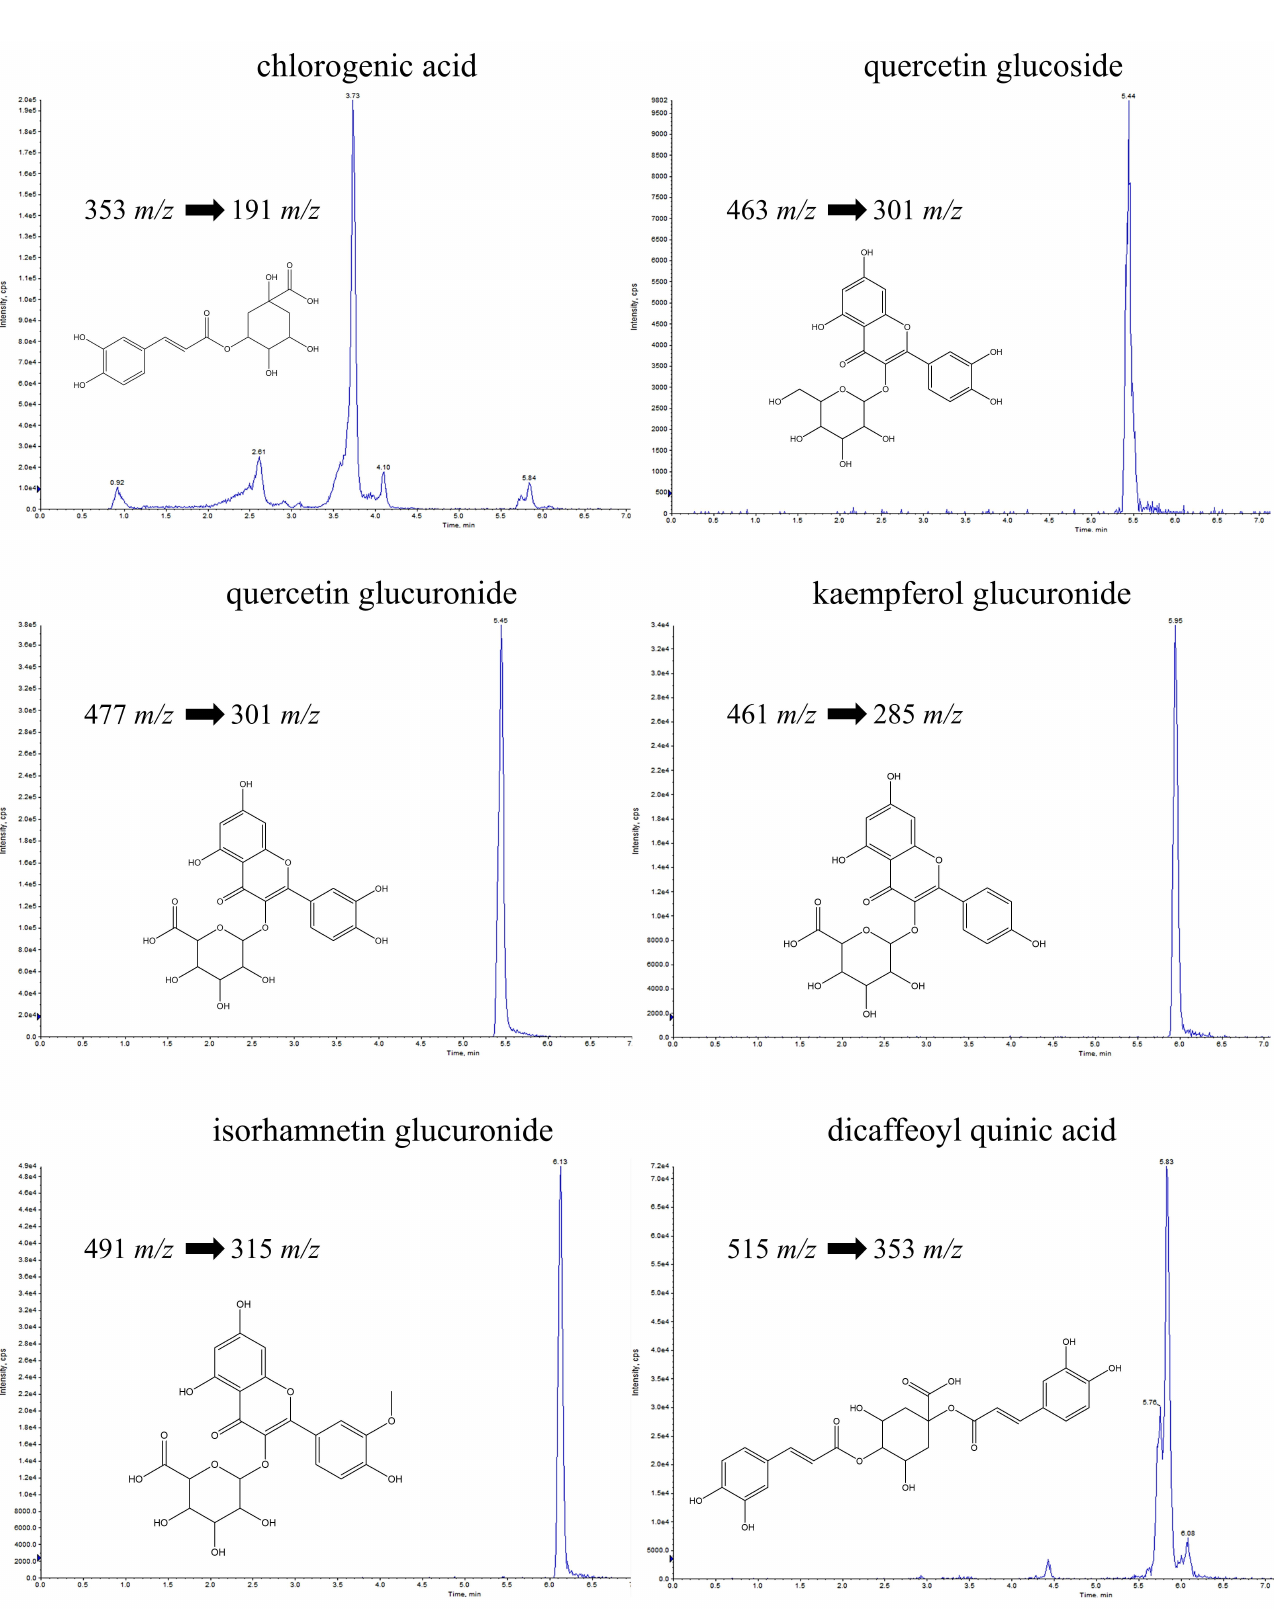
Figure 1. Q1/Q3 mass transitions for chlorogenic acid, quercetin glucoside, quercetin glucuronide, kaempferol glucuronide, isorhamnetin glucuronide, and dicaffeoylquinic acid obtained by UHPLC- ESI-QTRAP-MS/MS analysis and selected for MRM analysis of leaf extract